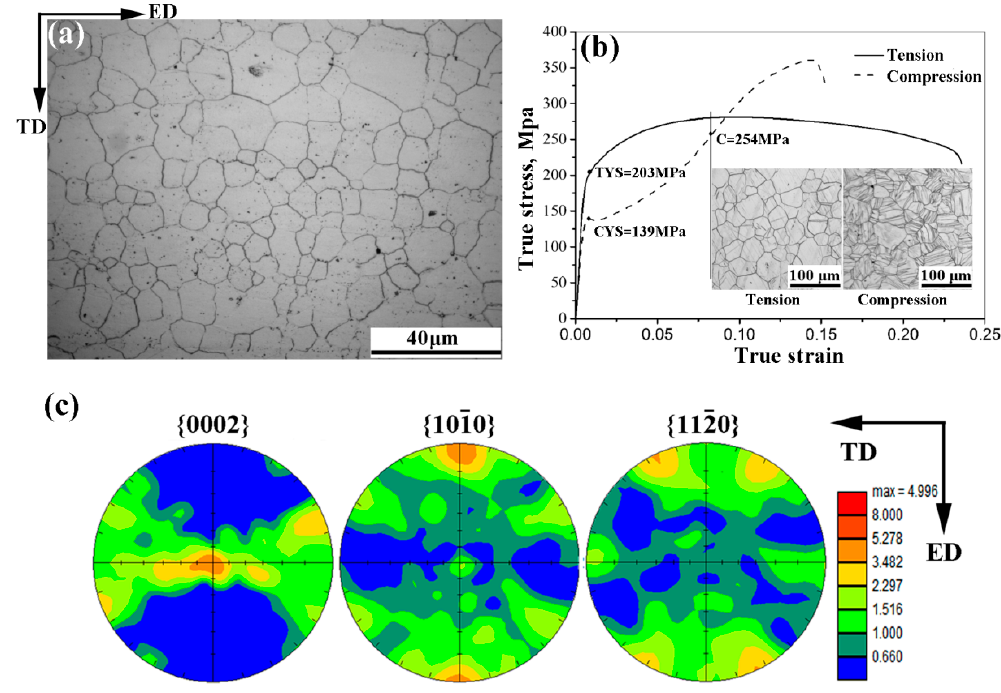
Figure 2. Microstructure and Mechanical behavior for as-extruded ZK61 alloy rods: ( a ) microstructure of as-extruded ZK61 alloy rods solution-treated at 400 °C for 48 h; ( b ) room-temperature true stress-strain curves in tension and compression; and, ( c ) {0002}, {10-10} and {11-20} pole figures.